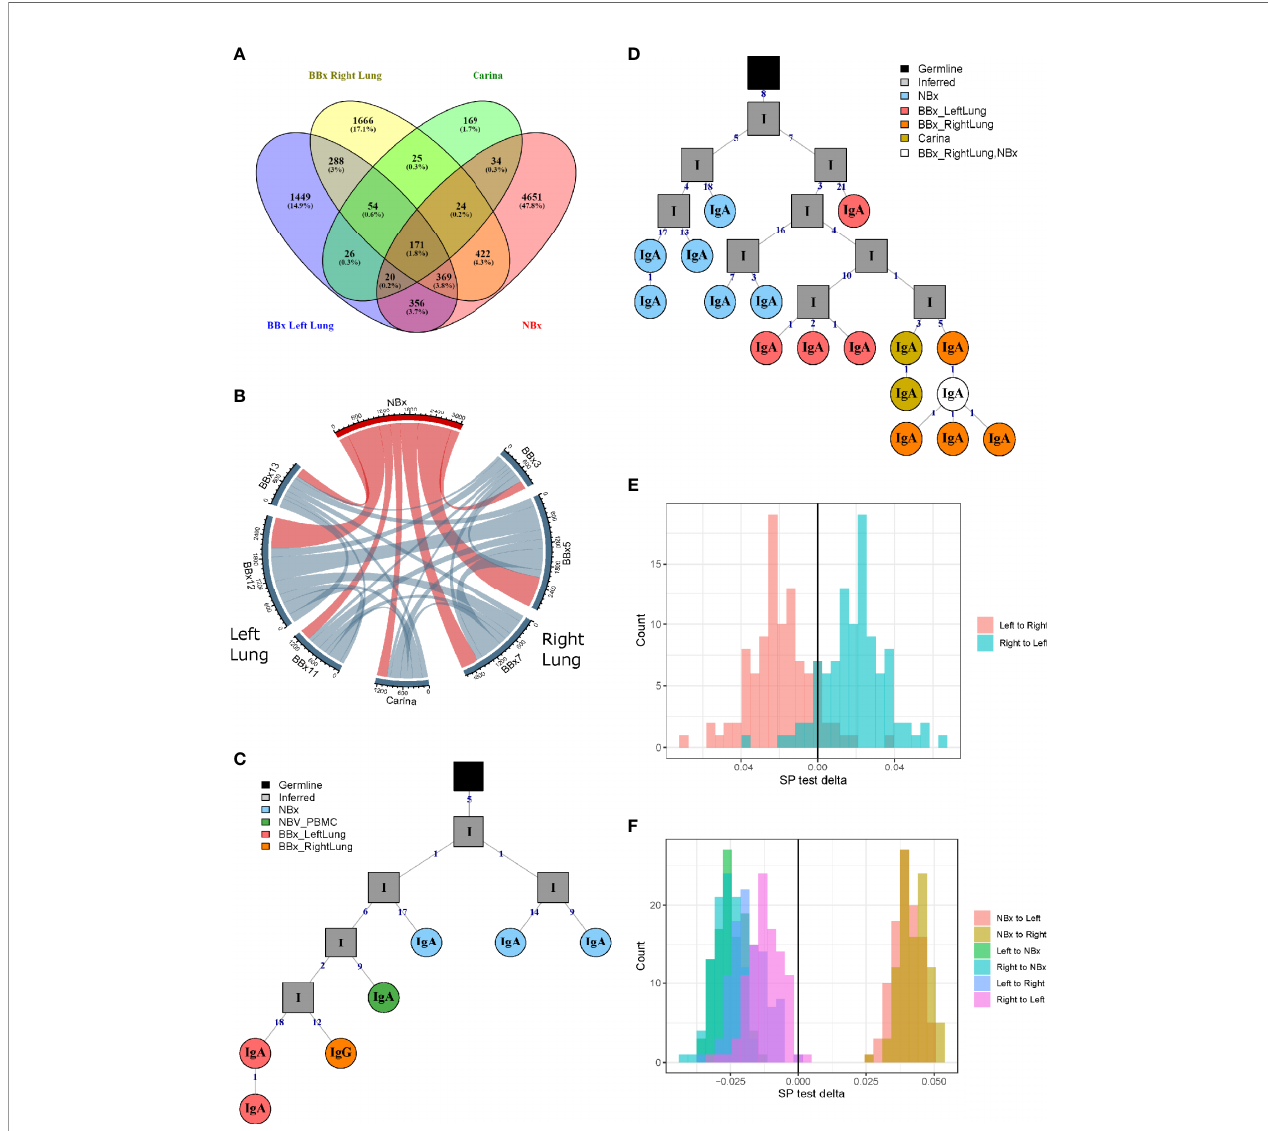
FIGURE 2 | B cells can traf fi c between the left and the right lungs, as well as from the carina and the nose to the lower airways. (A) Venn diagram showing the numbers (and percentages) of clones that overlap in the left and the right lungs, carina and the nose from the asthmatic patient AA07. (B) Clonal relationships between all seven bronchial biopsies (BBx) and the nasal biopsy (NBx) from AA07 were calculated and plotted in a Circos plot. The lines between regions indicate a clonal relationship and the numbers around the perimeter indicate counts of overlapped clones between two biopsies. Clones that overlapped more than two biopsies could be duplicated in the Circos plot. (C, D) Examples of clonal trees for two clones from AA07 spanning both lungs (right: orange and left: red), the nose (blue) and, for the clones in (C) , also the peripheral blood (green). The clone in (D) also has members from the carina (yellow). The clone in (C) has undergone isotype switching and contains both IgA and IgG sequences. The numbers along each of the branches indicate mutations. (E) Maximum parsimony phylogeography analyses show no enrichment for traf fi cking between the mucosa of the two lungs in either direction. (F) When the nasal clones are included, the analyses reveal enrichment for traf fi cking from the nasal mucosa to either lung (peach and yellow) whereas traf fi cking between the mucosa of the two lungs (purple and pink) shows no directional bias. There is negative enrichment for travel from either lung to the nasal mucosa (green and blue) con fi rming the directional preference for B cell traf fi cking from the nasal to the bronchial